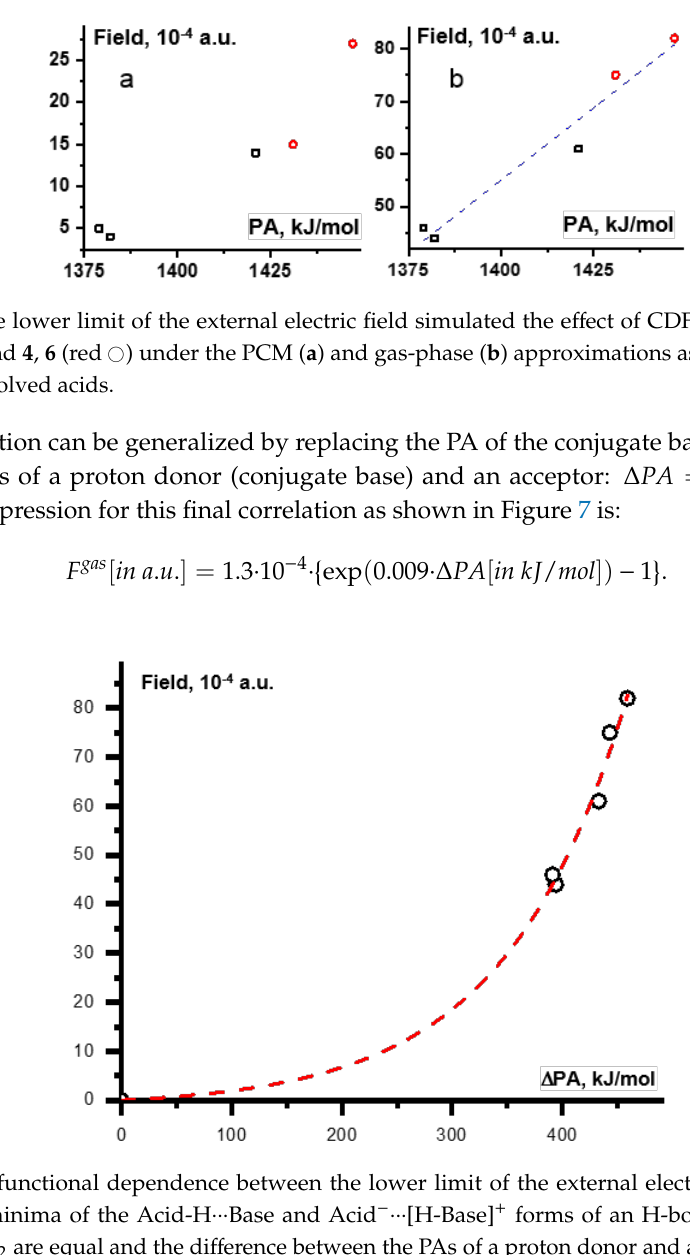
Figure 5. The lower limit of the external electric field simulated the effect of CDF 3 /CDClF 2 on 2 , 3 , 5 (black □), 4 , 6 (red ○ ), and 1 (blue  ) under the PCM ( a ) and gas-phase ( b ) approximations as a function of the p K a of the proton-donor.